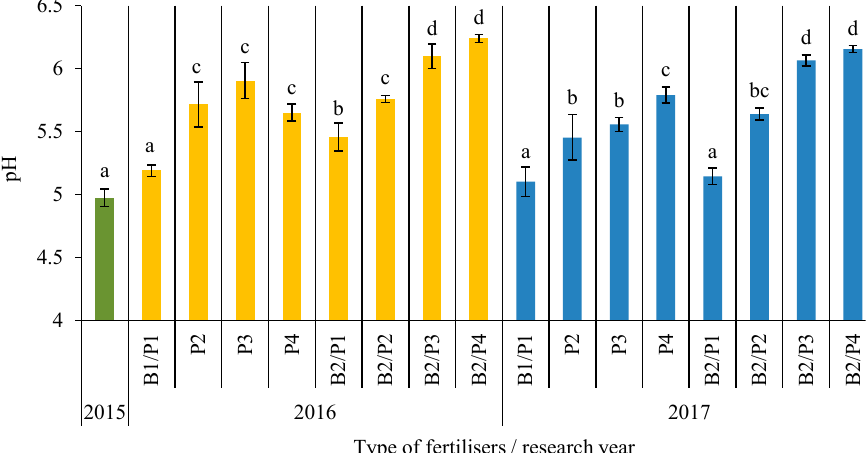
Figure 1. Values of soil pH prior to the experiment (2015) as well as following the first and the second year of cultivation in relation to the fertiliser applied. The mean values marked with the same letter do not differ significantly at a level of α ≤ 0.05 based on the results of the Bonferroni test.